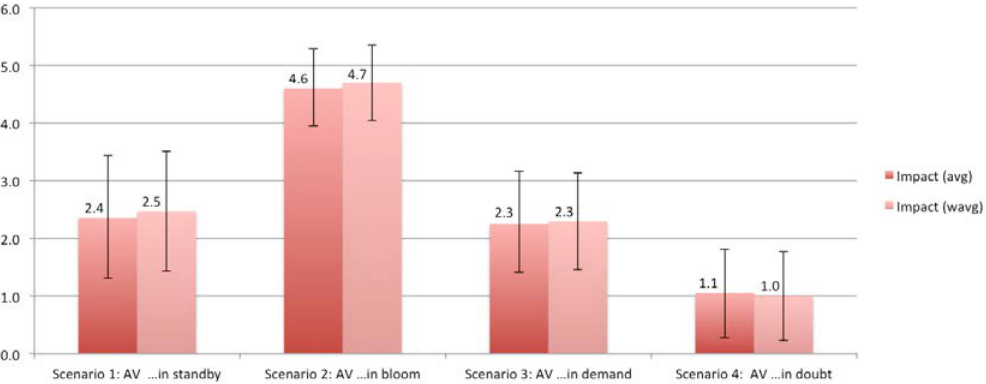
Figure 7. The average values of twenty experts responses on the overall impact (i.e. value of time, road capacity, and total VKT) of the four scenarios about development of automated vehicles in the Netherlands. Weighted average values are based on the participants’ level of confidence. Error bars depict standard